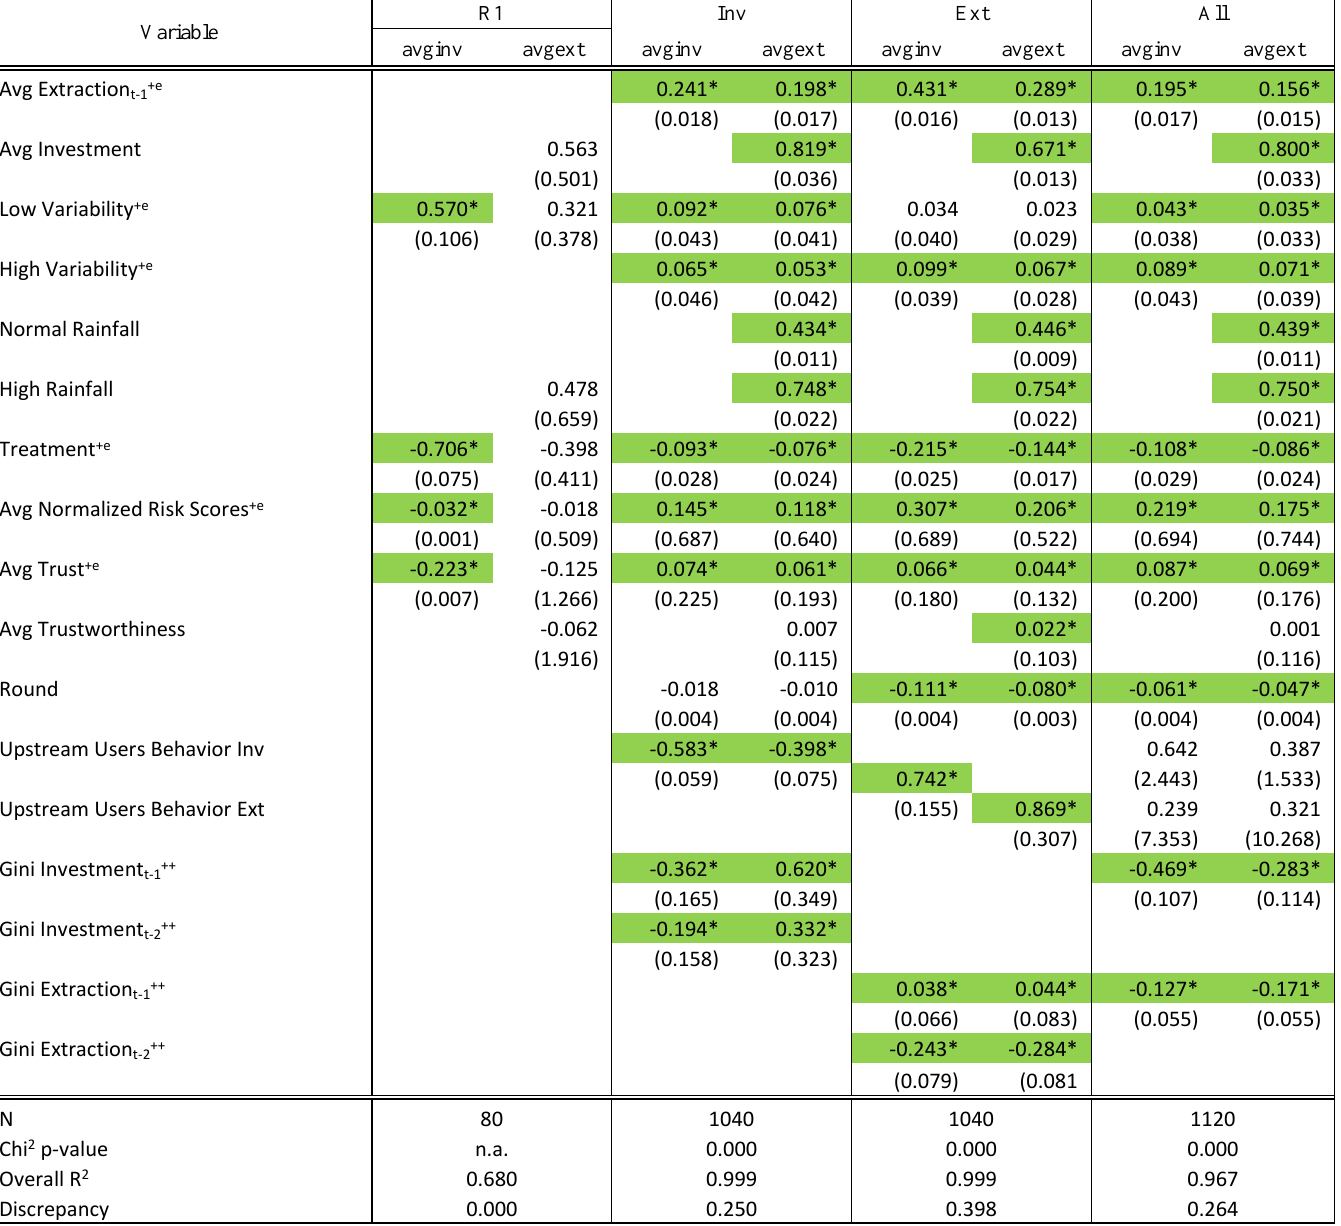
Table S3 . Results for the Model reported in eq. 3 at the group